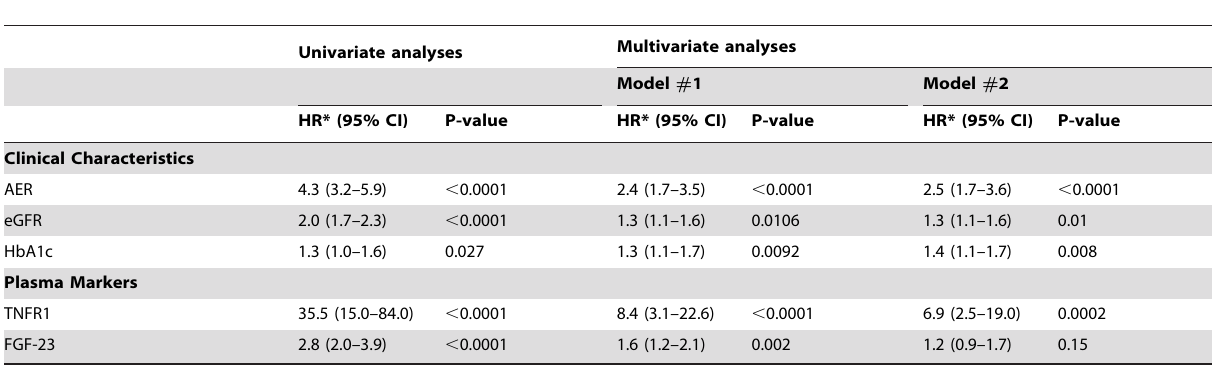
Table 3. Univariate and multivariate Cox proportional hazard models assessing risk of ESRD adjusting for relevant baseline clinical characteristics and plasma markers in subjects with T2D followed for 8–12 years.